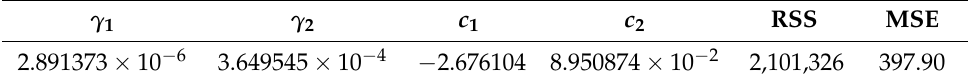
Table 8. Result of implementation of nlstac for pattern (17), RSS being residual sum of squares and MSE = RSS / n where n = 5281 is the number of observations.